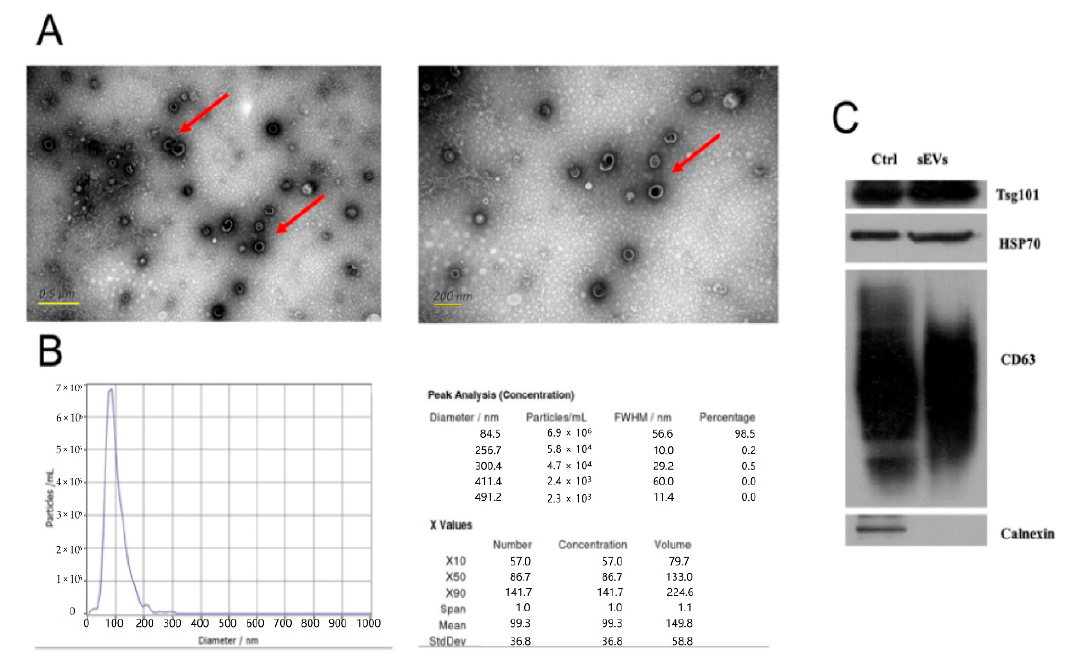
Figure 2. Exosomes derived from plasma supernatant were identified. ( A ) The morphology of sEVs was observed by transmission electron microscopy (TEM). The sEVs were highlighted by the red arrow. ( B ) sEVs concentrations and sizes were measured by nanoparticle tracking analysis (NTA) and the value was presented as the mean ± SD in the right table. ( C ) The positive biomarkers (CD63, Tsg101, and HSP70) and negative biomarker (Calnexin) of sEVs were detected by Western blot analysis, and the cell lysates of mesenchymal stem cell (MSC) were extracted as control.